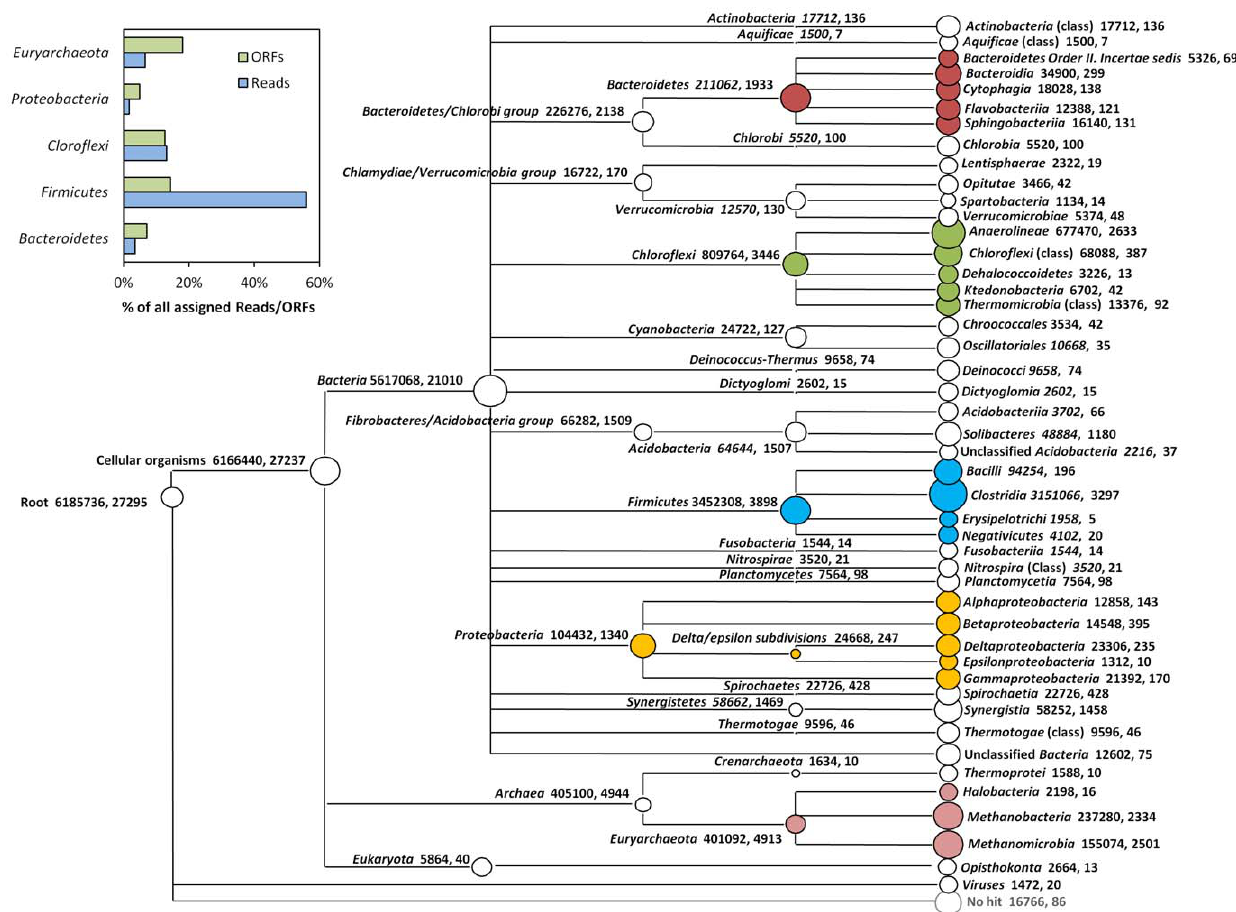
Figure 2. Taxonomy classification of the metagenome at class level based on RMORF approach. ORFs were assigned by default MEGAN LCA algorithm; only nodes with over 5 ORFs and 1000 reads assigned are shown. The circles are drawn based on the number of reads assigned to the particular node. The number after description denotes, respectively, the sum of reads and ORFs assigned below the particular node. The circles are colored according to its classification at phylum level as in Figure 1. Insert: the relative distribution of annotated reads and ORFs in the major phyla.